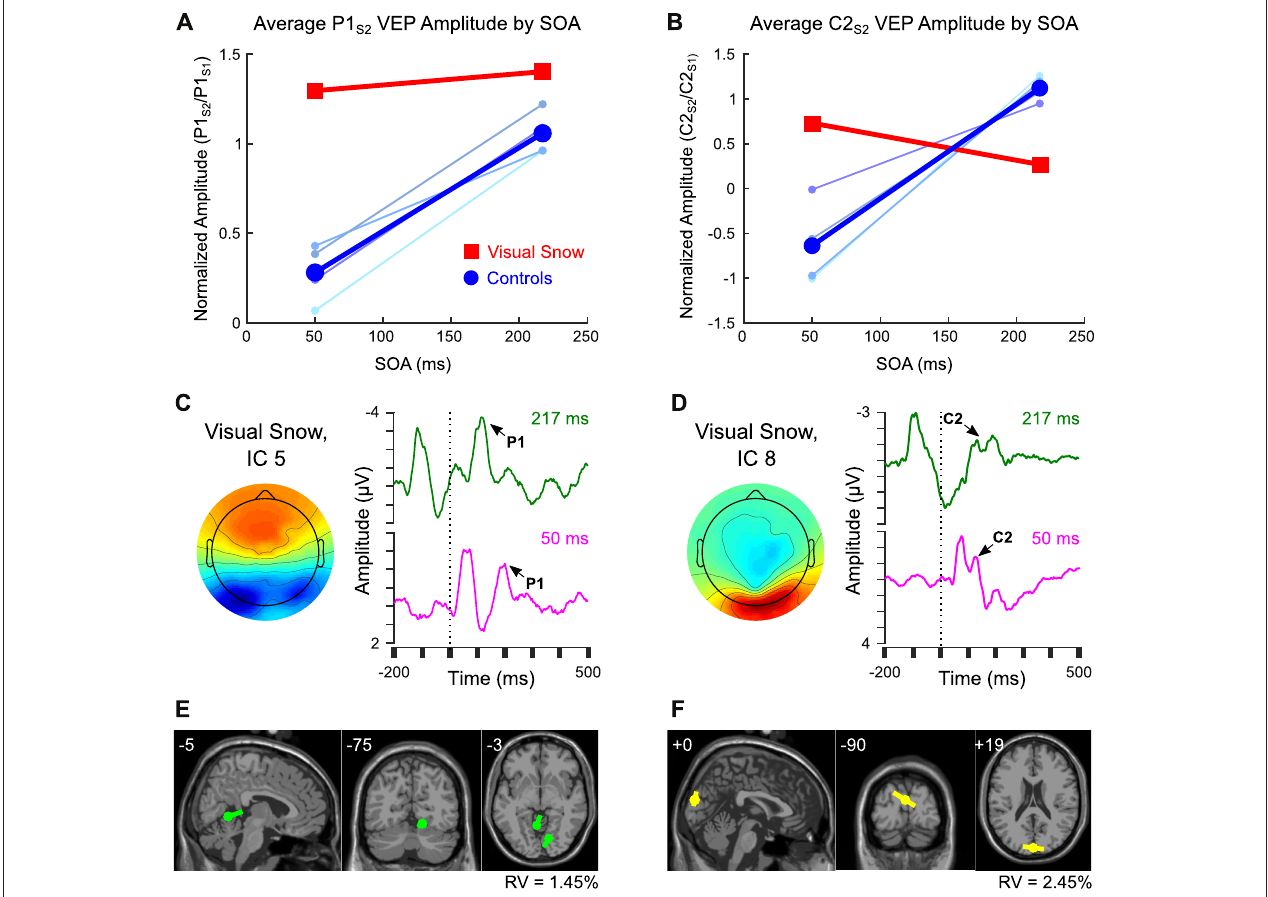
FIGURE 3 | Comparison of pattern-onset P1 and C2 adaptation effects. (A,B) Sensor-level VEP amplitude for 50ms and 217ms SOA in controls (blue) compared to the visual snow patient (red) for (A) the P1 response vs. (B) the C2 response. Colors for individual control participants correspond to labels from Figure 1C . (C,D) Comparison of ICs from one session within the visual snow patient associated with the (C) P1 vs. (D) C2 VEPs, including scalp topography and back-projected grand average waveform for 217ms SOA (green) and 50ms SOA (fuschia). (E,F) Equivalent current dipole fitting for (E) IC 5 associated with the P1, and (F) IC 8, associated with the C2